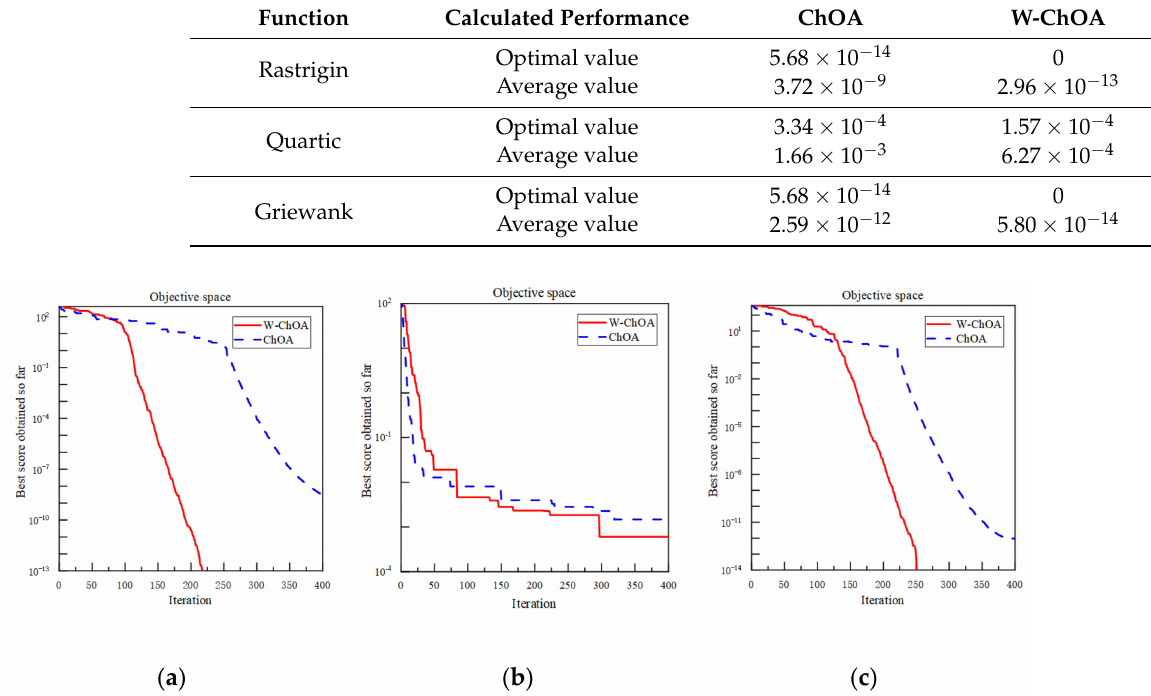
Figure 3. Convergence curves of three benchmark functions. ( a ) Rastrigin function. ( b ) Quartic function. ( c ) Griewank